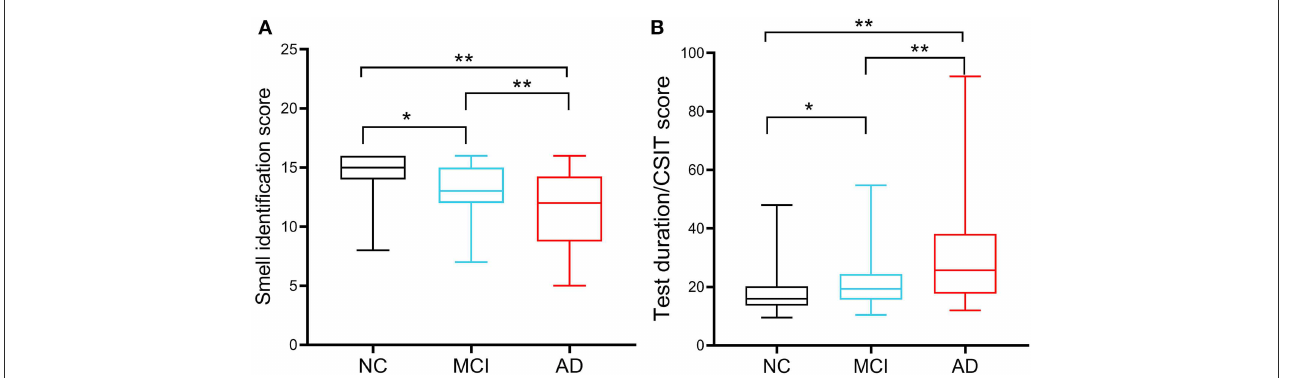
FIGURE1 Chinese smell identification score and accurate identification efficiency of the participants. (A) Comparison of Chinese smell identification scores in cognitive normal controls (NCs; n = 188), patients with MCI ( n = 136), and patients with AD ( n = 42). (B) Accurate identification efficiency was calculated by the ratio of the used testing time to the achieved scores. * P < 0.05, ** P < 0.01.